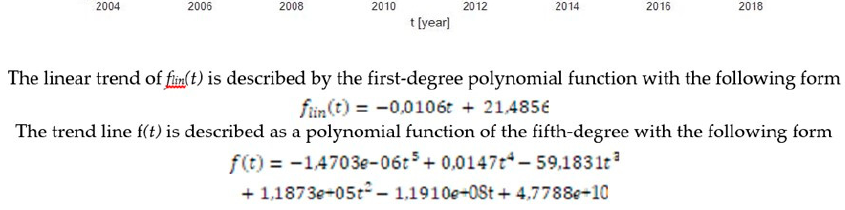
Figure 7. Trends of changes in the frequency of severe accidents in civil engineering over time.